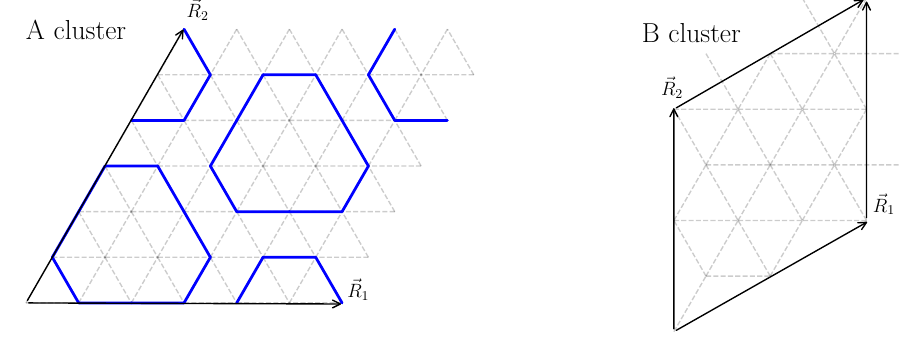
Figure 2: The two types of clusters considered in the numerical study of the dimer model. A schematic representation of the unit cell is shown for the 6 × 6 type A